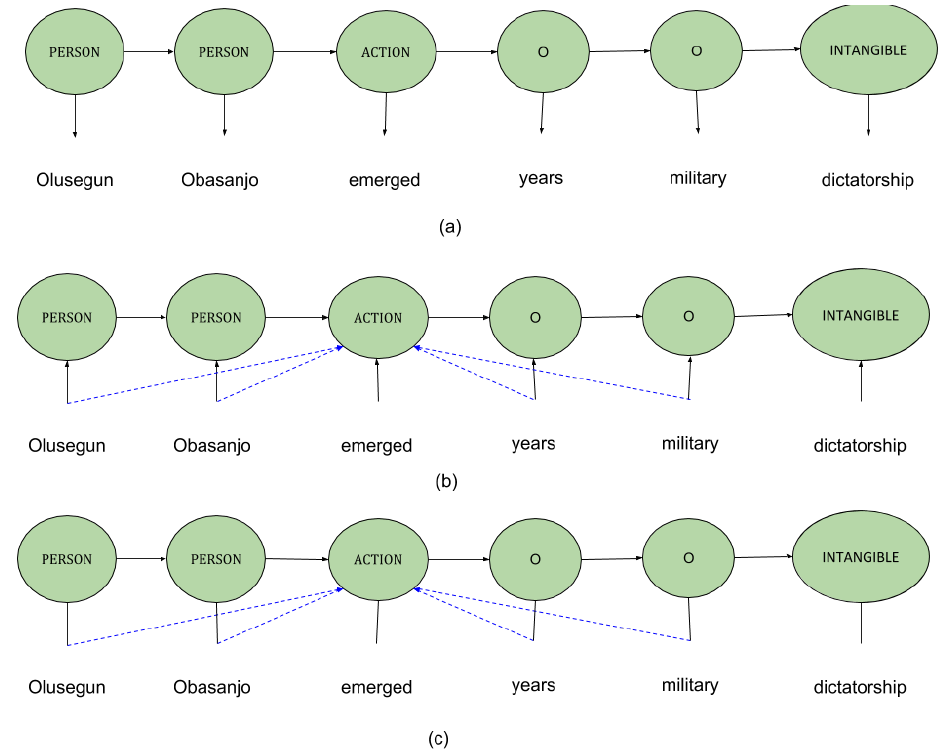
Figure 1. Differences between the main approaches for sequence tagging. ( a ) HMM: it tries to establish the probability of p ( y | x ) from p ( x | y ) ; ( b ) MEMM: the probability of p ( y | x ) is calculated directly from the observations, as shown by the direction of the arrow. The dotted arrows implies that the calculation of probability takes into account features over distant observations; ( c ) CRF: represented by an undirected graph. It also takes into account features over distant